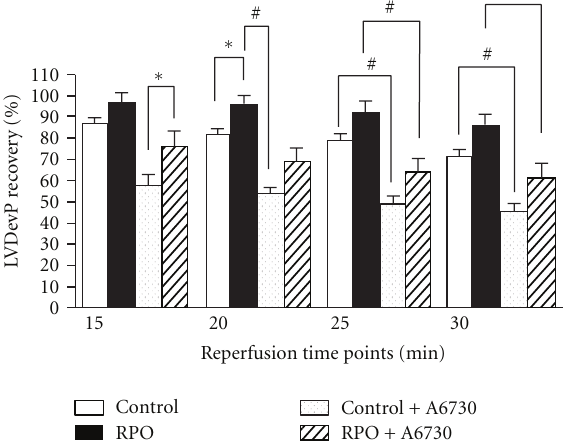
Figure 4: E ff ect of RPO and Akt-1-1/2 inhibitor (A6730) on LVDevP recovery (%). Results expressed as means ± SEM ( ∗ P < 0 . 05 and # P < 0 . 01 for indicated groups). Controls ( n = 7), RPO ( n = 7), control + A6730 ( n = 5), and RPO + A6730 ( n = 5).